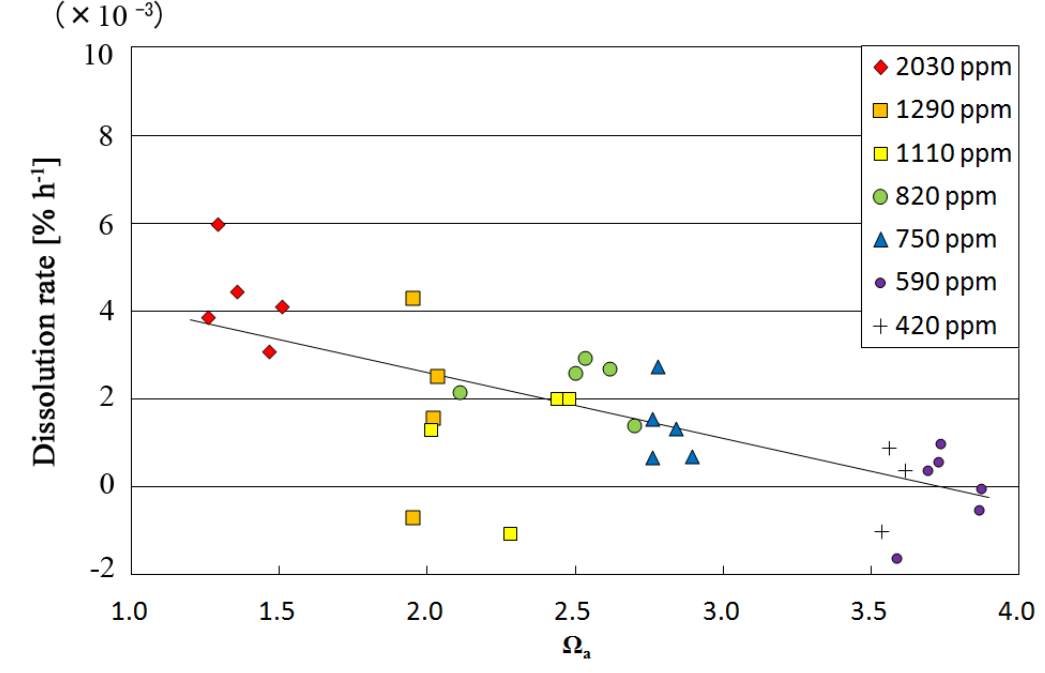
Fig. 6. The relationship between average dissolution rate and (cid:127) a (bulk).